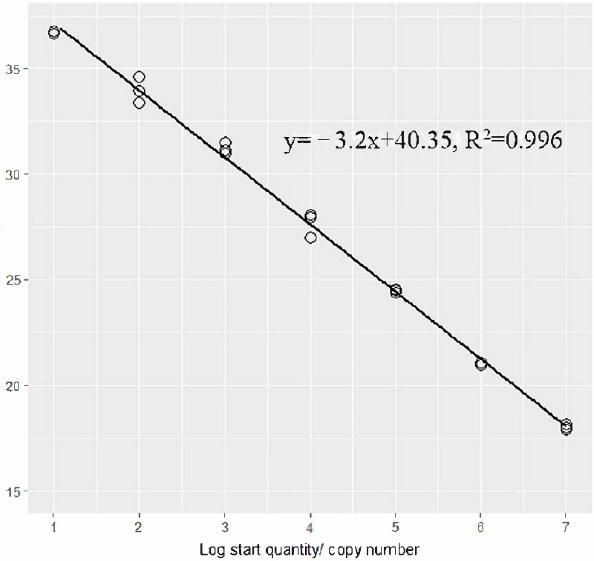
Figure 3. The standard qPCR curve of the Fenneropenaeus chinensis COI gene. The x -axis represents the logarithm of the plasmid DNA/cDNA concentration; the y -axis indicates the threshold cycle value of the qPCR.